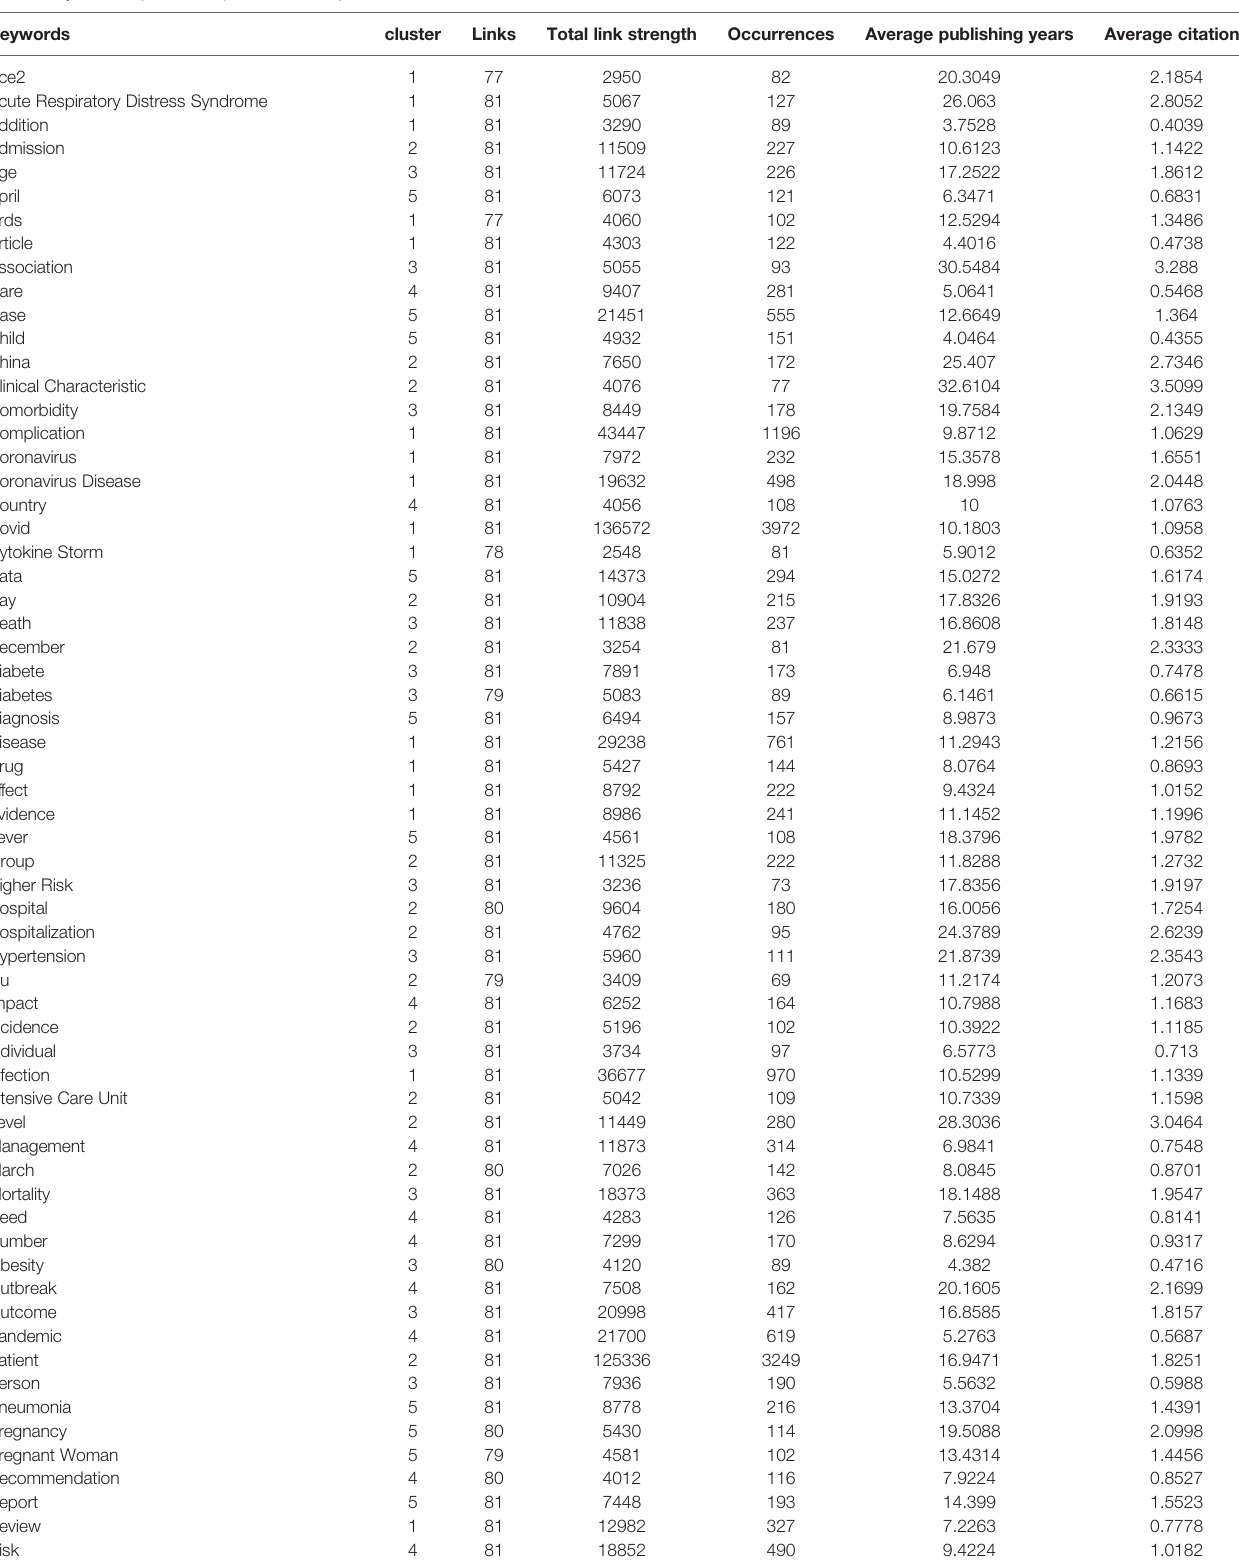
TABLE 3 | The analytic consequence of 82 keywords with from 69 to 3972 occurrence times.